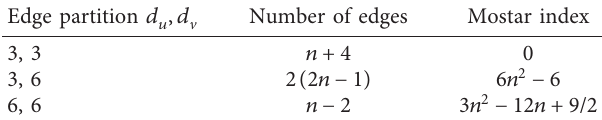
Table 12: Edge partition of chain silicate network of odd order.